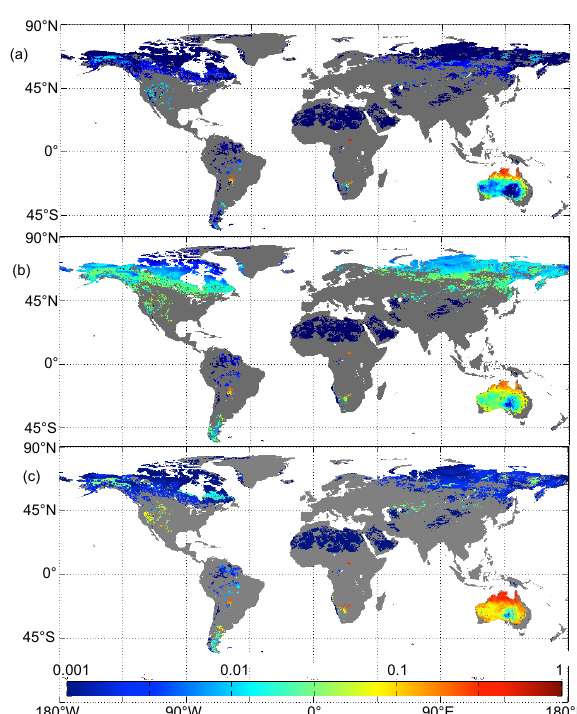
Fig. D1. Modelled mean fire frequency with parameters optimised against (a) MODIS, (b) L3JRC and (b) GFED-SF observations for areas with up to 0.1 inhabitantskm − 2 .